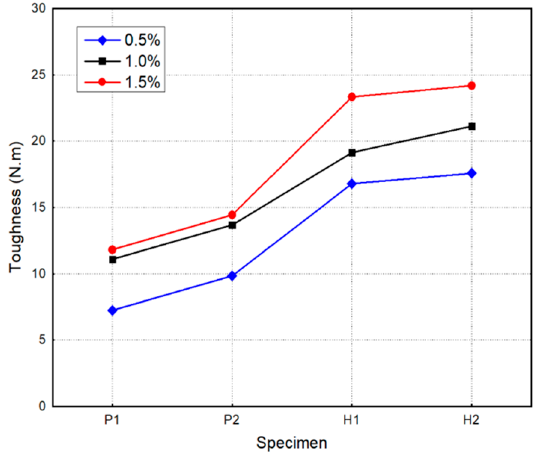
Figure 20. Energy absorption capacity (toughness).